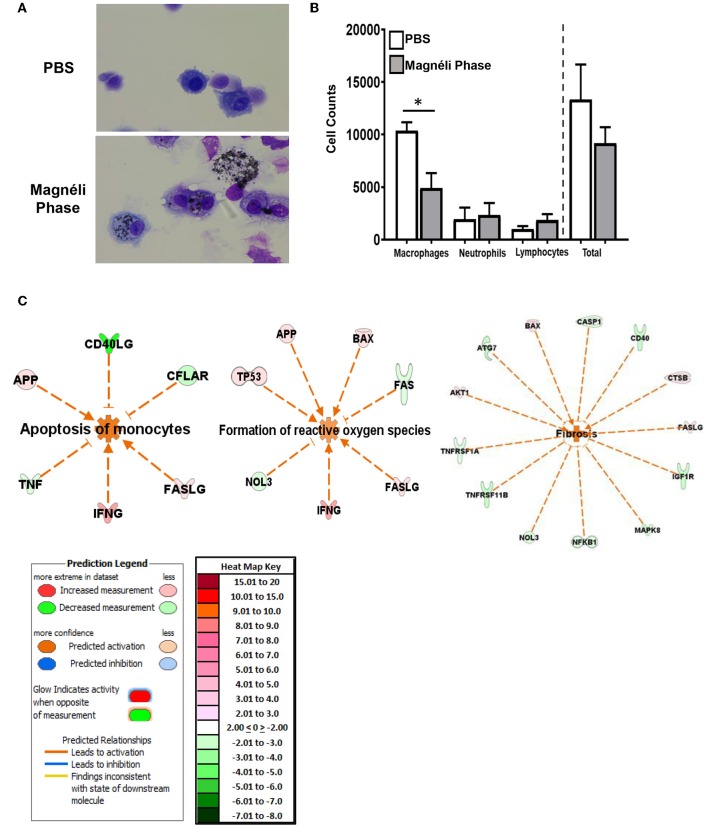
Magnéli phases concentrate in pulmonary macrophages, resulting in significant dysfunction. (A) Representative images of BALF cytology from PBS and Ti6O11 (100 ppm) treated mice. (B) Differential cell counts in the BALF after treatment with PBS, Ti6O11, or LPS. (C) Gene expression profiling and analysis using Ingenuity Pathway Analysis software identified gene transcription patterns associated with increases in apoptosis, formation of reactive oxygen species, and wound healing/fibrosis. Data are expressed as mean ± SEM (n = 3 mice per PBS treated group, n = 7 mice per Ti6O11 treated group, and n = 4 per LPS treated group). *p < 0.05.